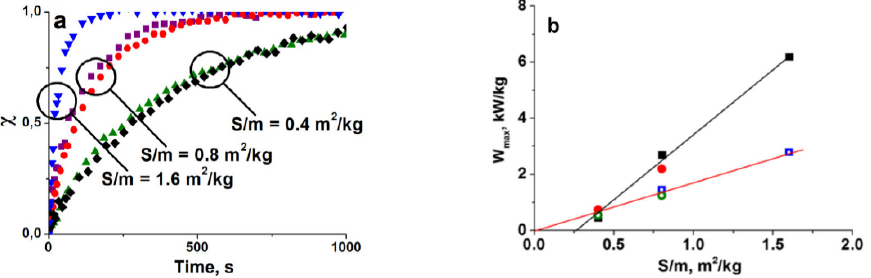
Figure 6. ( a ) Dimensionless curves of methanol adsorption for the compact carbon layers with various (S/m)-ratios indicated on the graph: grain size D gr = 0.8–0.9 mm, layers number N = 2 ( ▼ ); 0.8–0.9 mm, N = 4 ( ■ ); 1.6–1.8 mm, N = 2 ( ● ); D gr = 0.8–0.9 mm, N = 8 ( ) and D gr = 1.6–1.8 mm, N = 4 ( ▲ ); ( b ) Maximal specific power W max against the (S/m)-ratio for the adsorption runs. D gr = 0.8–0.9 mm ( ■, ) and 1.6–1.8 mm ( ● , ). Consolidated (solid symbols) and granulated layers (empty symbols). Reprinted/adapted with permission from Ref. [72]. (Copyright 2017), Elsevier.